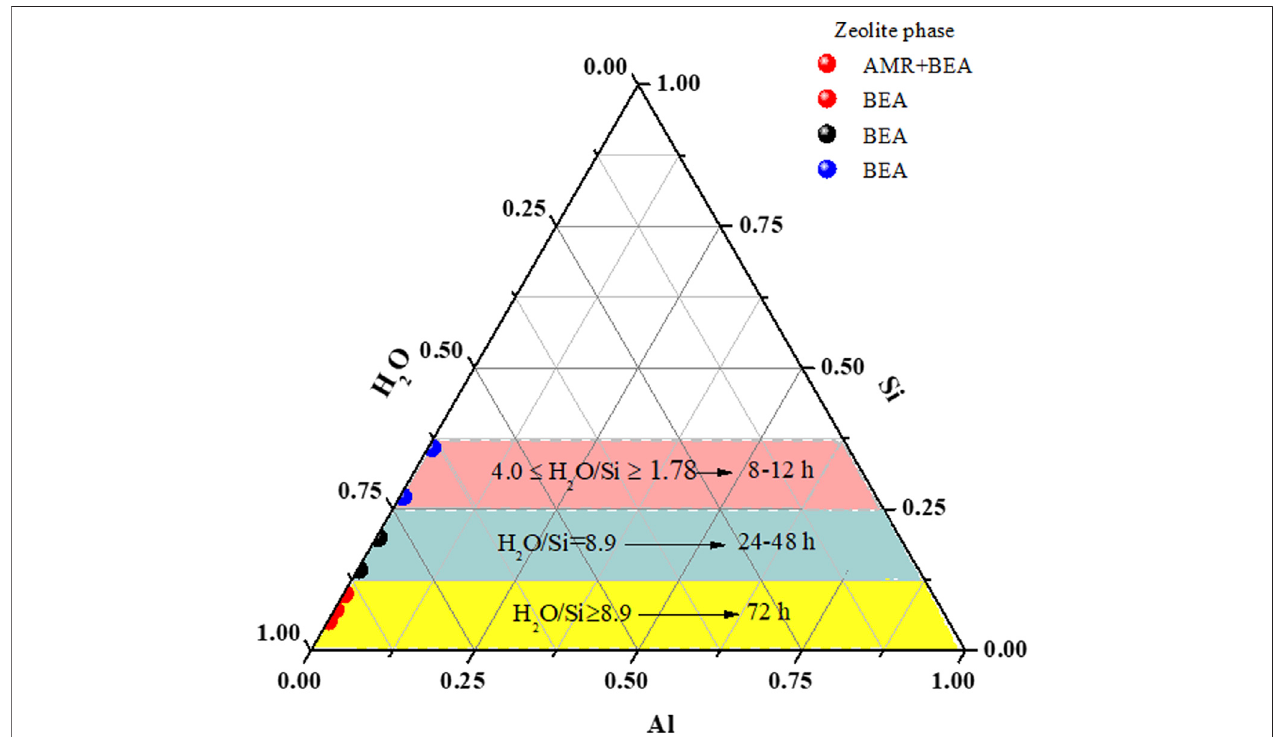
FIGURE 2 | Ternary diagram representing rapid phase formation as a function of reduced molar H 2 O. *AMR (cid:2) amorphous.